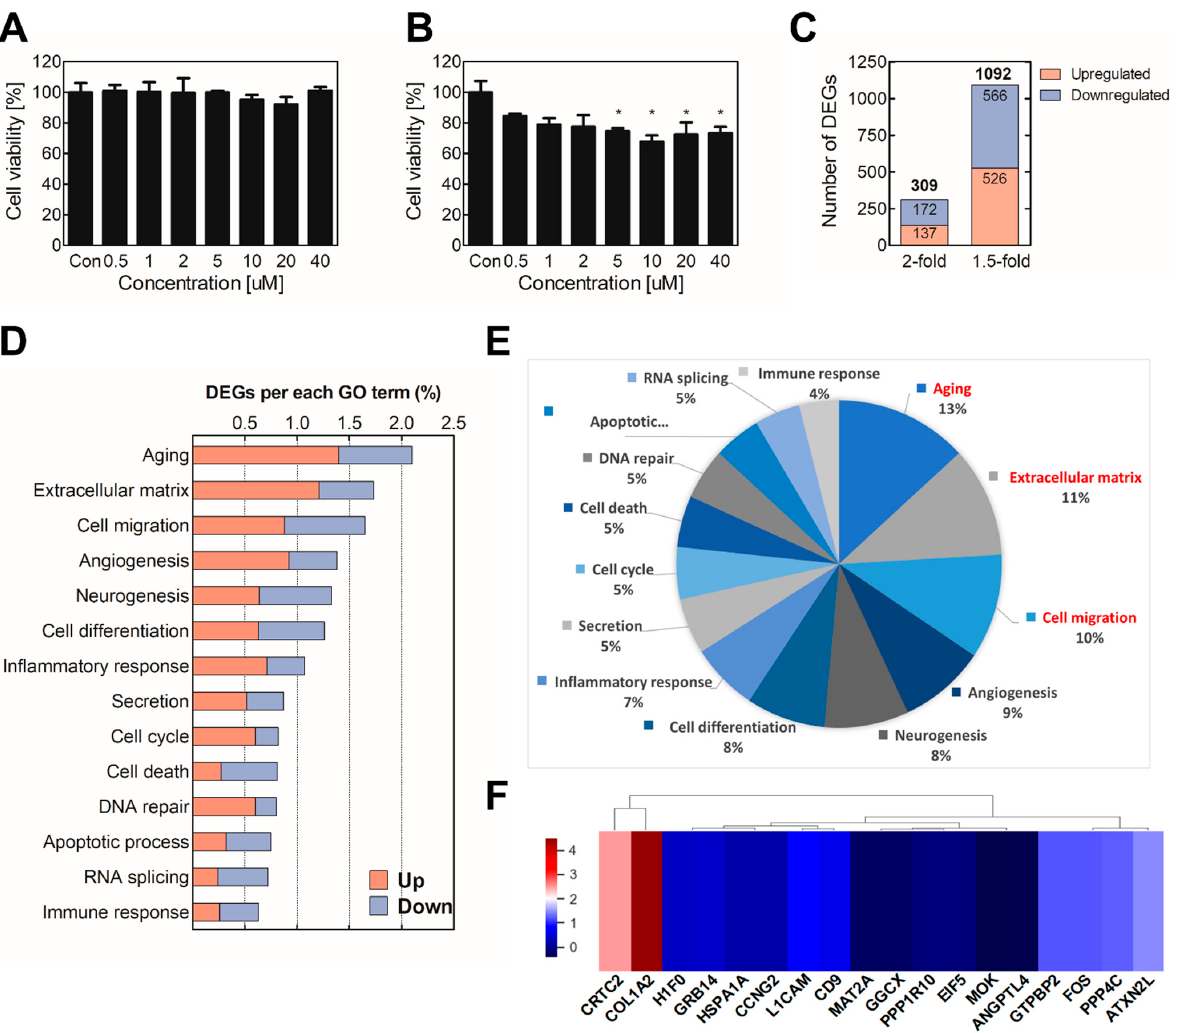
Figure 2. Identification of biomarker candidates for assessment of sodium cyanide exposure. To determine the cytotoxicity of sodium thiocyanate, BEAS-2B cells were treated with various concentrations of sodium thiocyanate for ( A ) 4 h or ( B ) 24 h. Cell viability was analyzed using the WST assay. Then, mRNA quan-seq was conducted using the total RNA of the cells treated with sodium thiocyanate. ( C ) The differential expression analysis was performed by comparing the mRNA levels of the sodium-thiocyanate–treated cells with those of the vehicle-treated control cells. ( D ) GO analysis was conducted using the DEGs ( ≥ 2 folds). ( E ) The proportions of the GO terms are presented in a circular diagram. ( F ) The heatmap of hierarchical clustering of the biomarker candidates was constructed using the z-scores of the genes. Red and blue indicate upregulation and downregulation, respectively. Each result is the mean ± SEM of at least three independent experiments. * p < 0.05. GO, gene ontology; DEG, differentially expressed gene.